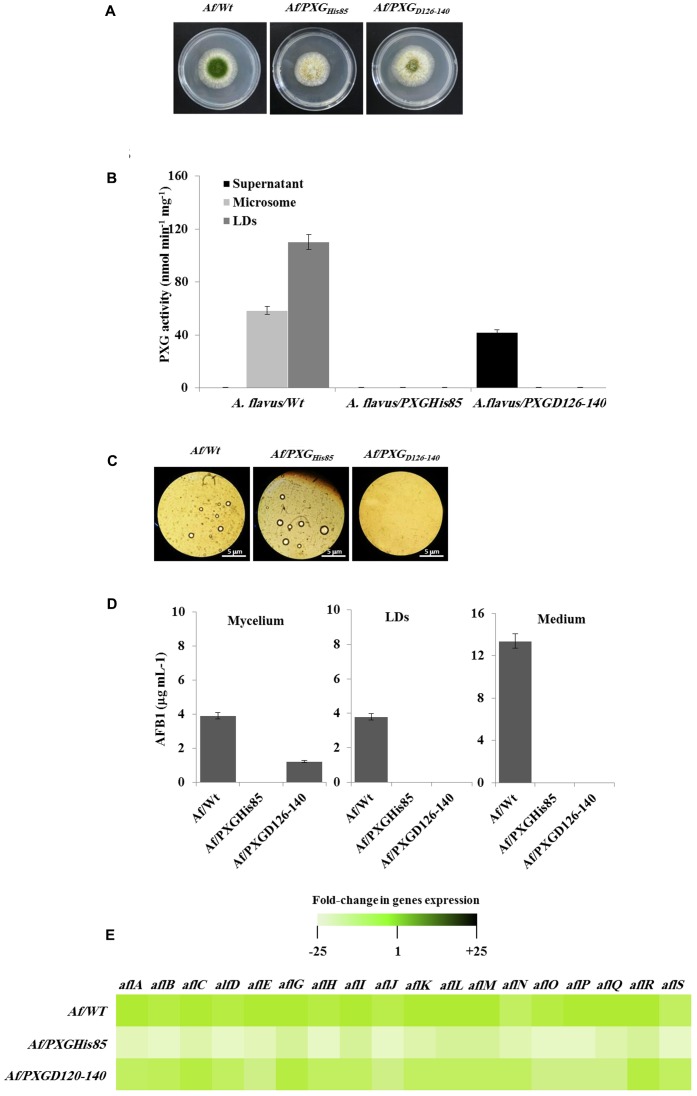
Effect of AfPXG enzymatic activity and the absence of its transmembrane domain on biosynthesis and/or export of AFB1. (A) Growth of Af/AfPXGHis85 We have changed ““textitAf/AfPXGHis85” and ““textitAf/PXGD126–140” as ““textitAf/AfPXG$_“textHis85′′and“∖textitAf/PXG$∖textD126-140”, respectively here and throughout. Kindly confirm if this if fine., Af/PXGD126-140 lines compared with Af/WT. (B) PXG activity in supernatant (S), microsomes (M), and lipid droplets (LDs) isolated from the Af/AfPXGHis85, Af/PXGD126-140 lines compared with Af/WT. (C) Light micrographs of the isolated LDs from fungal tissue Af/AfPXGHis85, Af/PXGD126-140 lines compared with Af/WT, respectively, on day 7. Recovered LDs were observed under a light microscope and the images were taken at a magnification of 40×. Bar represents 5 mm. (D) Quantification of AFB1 in the fungal mycelium, LDs and in the culture medium of Af/AfPXGHis85, Af/PXGD126-140 lines compared with Af/WT, respectively, on day 7. (E) Transcript levels of AFB1-biosynthesis genes in fungal tissue of Af/AfPXGHis85, Af/PXGD126-140 lines compared with Af/WT were evaluated by qRT-PCR. The color scale (white–green–black) indicates relative changes of transcript abundance of –25-, 1-, and +25-fold, respectively. For each gene, the expression level in Af/WT was defined as 1. The measurements were done in triplicate. Values are the means ± SD (n = 3).